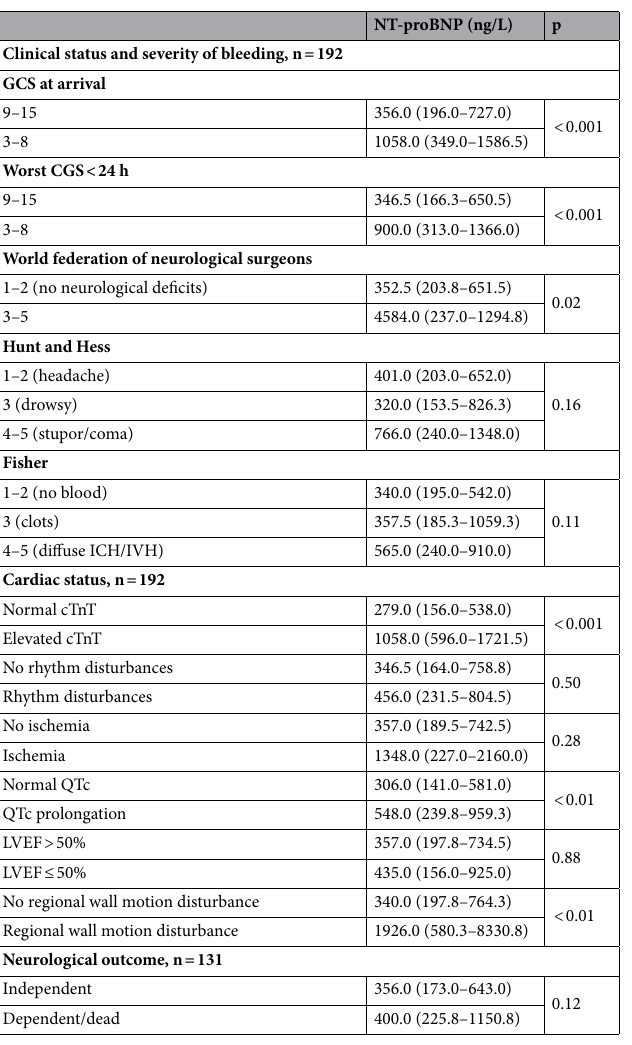
Table 6. NT-proBNP concentrations at day 1 according to clinical and cardiac status, and neurological outcome at day 90. cTnT cardiac troponin T, GCS Glasgow coma scale, LVEF left ventricular ejection